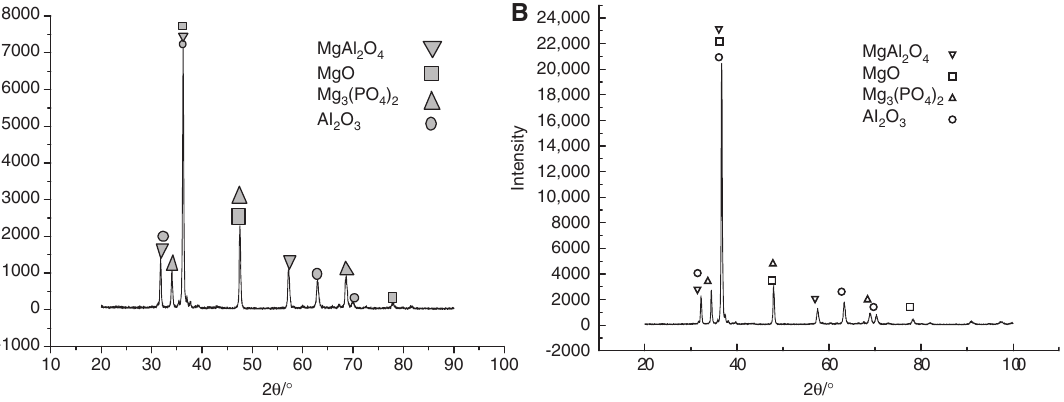
Figure 5 MAO coating XRD diagram with ultrasonic waves. (A) Ceramic coating XRD diagram without ultrasonic waves. (B) Ceramic coating XRD diagram with ultrasonic waves.